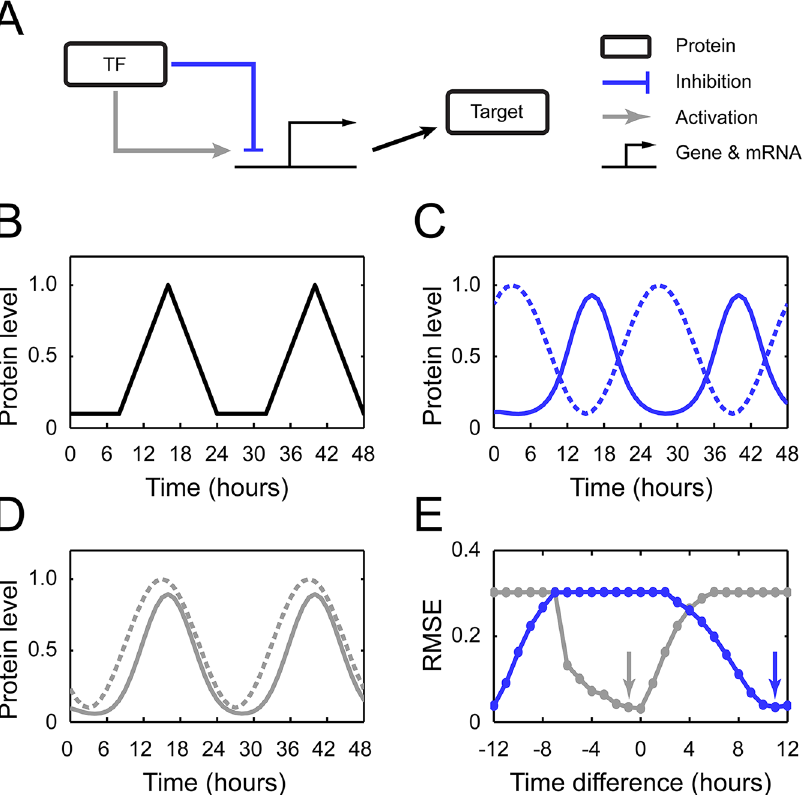
Fig 4. Effect of an inhibitor or activator on the generation of cuspidate profiles. (A) A transcription factor (TF; inhibitor or activator) regulates gene expression and thereby affects the protein production. (B) Schematic diagram of a cuspidate waveform. (C, D) Sinusoidal profile (dotted) of an inhibitor (C) or activator (D), which regulates the target gene to produce its proteins (solid). Given the inhibitor or activator levels, the target gene transcription, translation, and product degradation were simulated with the parameters that best fit the desired, cuspidate expression profile in (B). (E) For a given phase difference between a transcription factor (inhibitor or activator) and its target gene ’ s protein, plotted is the resulting deviation of the target gene ’ s protein profile from the cuspidate profile. The horizontal axis represents a peak time difference between each transcription factor ’ s profile and the target gene ’ s desired protein profile in (B): a sign is negative if the former profile has more advanced peak time than the latter, otherwise it is positive. The vertical axis represents a root mean square error (RMSE) between the target gene ’ s actual and desired protein profiles when the target gene expression was simulated with the parameters that best fit the cuspidate protein profile in (B). The smaller the RMSE, the more cuspidate profile the target gene has. The inhibitor case is shown in blue, and the activator case is shown in gray. Arrows in blue and gray correspond to the conditions for (C) and (D), respectively. Sinusoidal waves were used for the transcription factor profiles as illustrated in (C, D). Qualitatively similar results are reproduced by other various waveforms (S8 Fig). For an alternative definition of peak time differences along the horizontal axis, use of the peak times of the target gene ’ s actual, rather than desired, profiles did not essentially change the peak time differences.